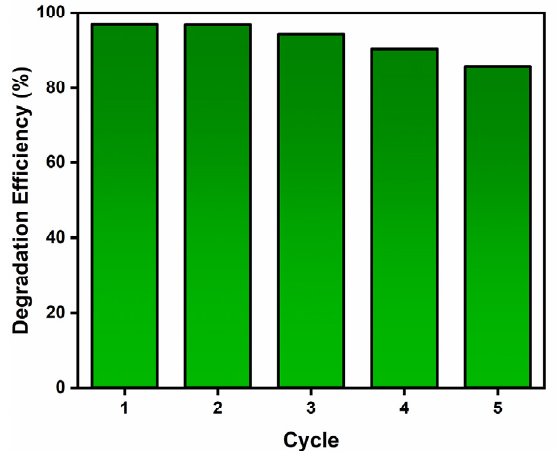
Fig. 11. Reusability and stability for catalytic degradation of pH-12 controlled synthesized TiO